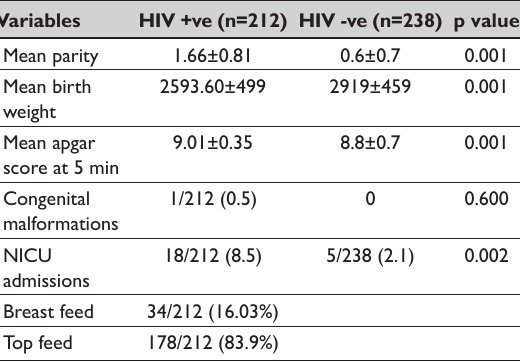
Table 3: Comparison of neonatal outcome among